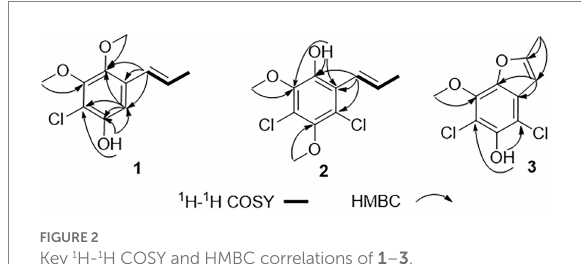
FIGURE 2 Key 1 H- 1 H COSY and HMBC correlations of 1 – 3